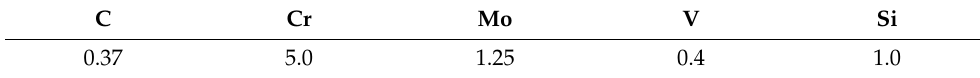
Table A2. Chemical composition of H11 tool steel (DIN 1.2343) in mass % [22].